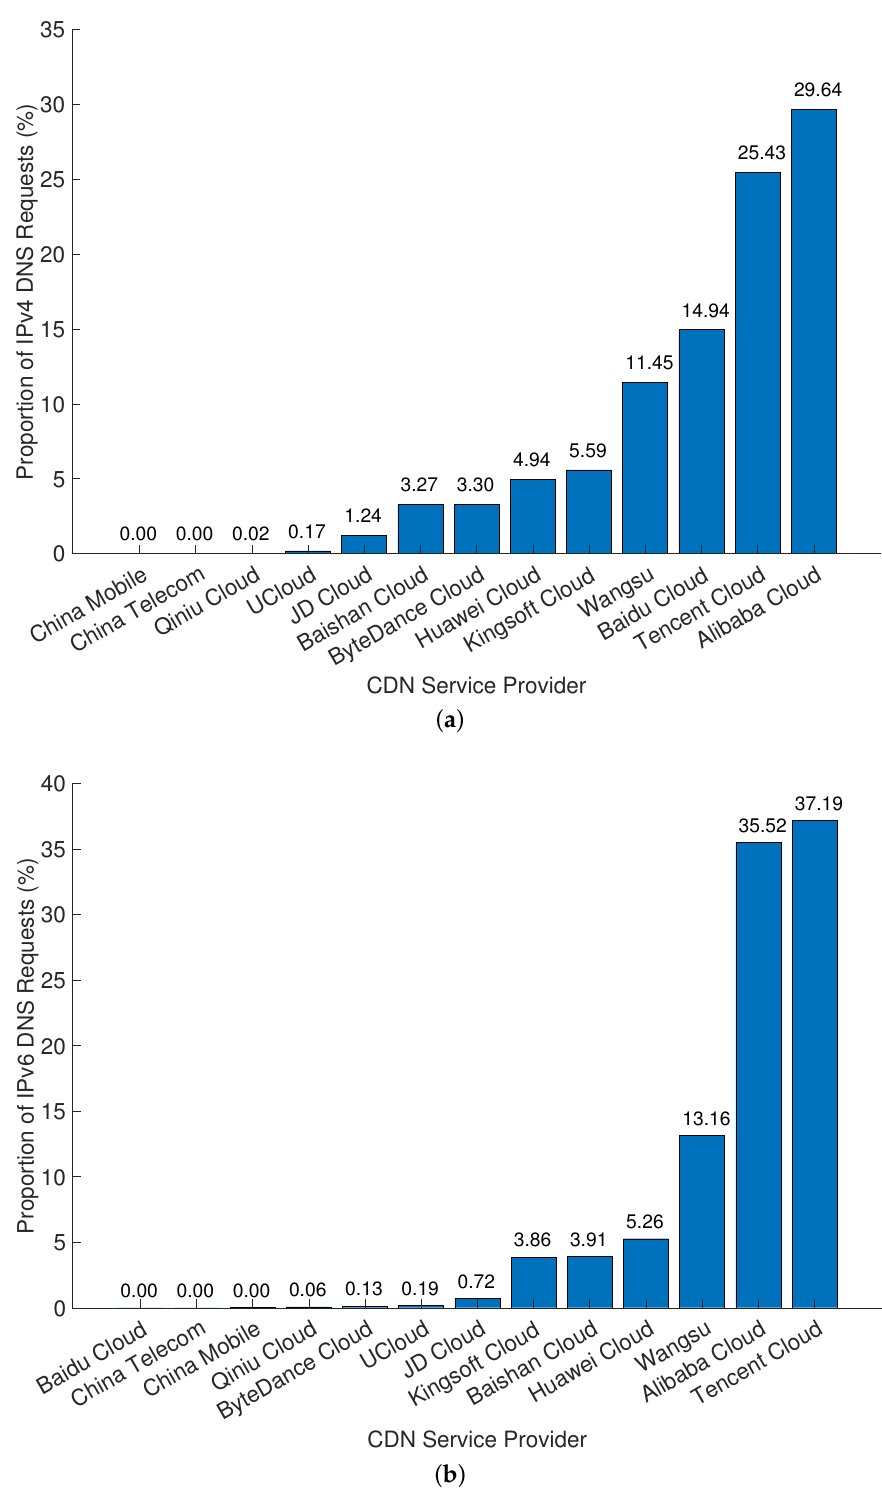
Figure 4. ( a ) Proportion of DNS requests using IPv4 for different CDN service providers. ( b ) Proportion of DNS requests using IPv6 for different CDN service